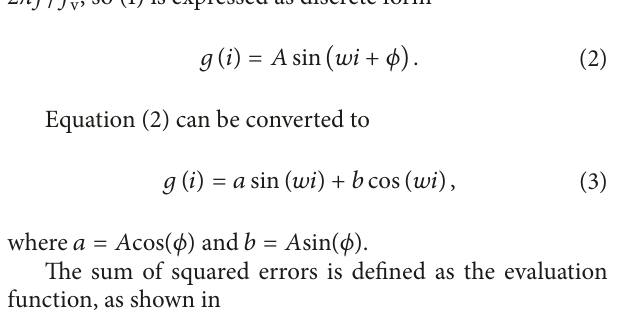
Based on the sampling frequency 𝑓 v , sampling time 𝑡 𝑖 = (𝑖 = 1, 2, . . . , n ) , and angular frequency 𝑤 = 𝑖 ⋅ Δ𝑡 = 𝑖/𝑓 v 2𝜋𝑓/𝑓 v , so (1) is expressed as discrete